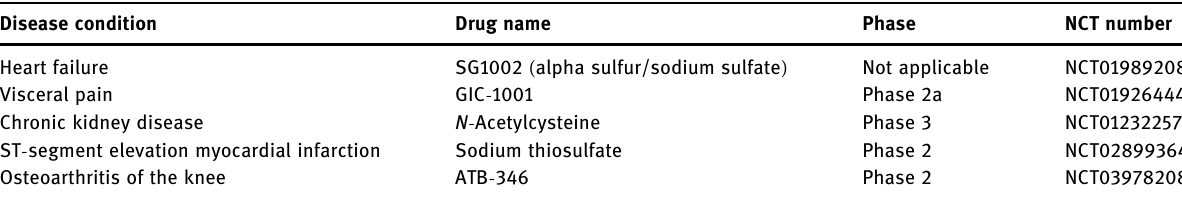
Table 1: H 2 S donors in clinical trials for disease treatment Disease condition